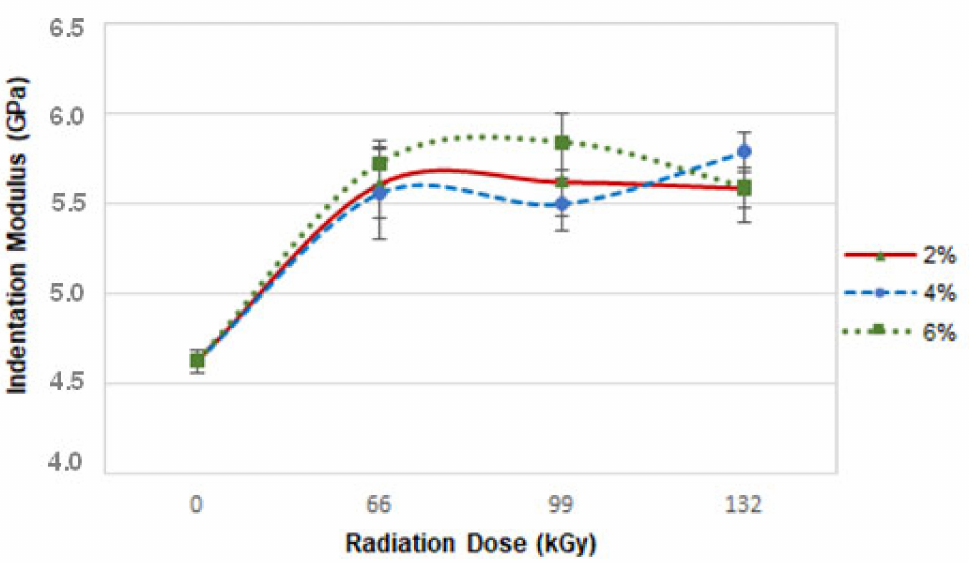
Figure 6. Dependence of indentation modulus on radiation intensity and TAIC concentration.